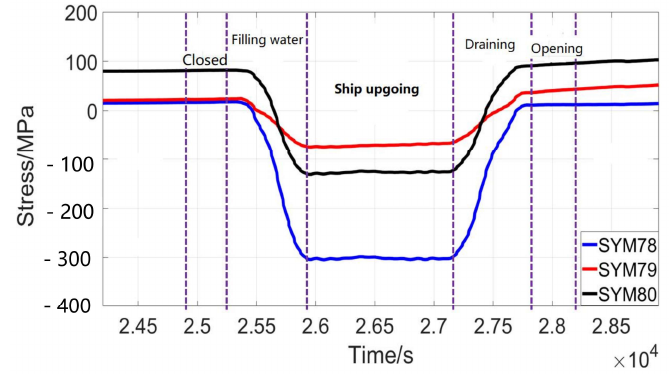
Figure 8. Stress signal waveform in a navigation cycle of miter gate.